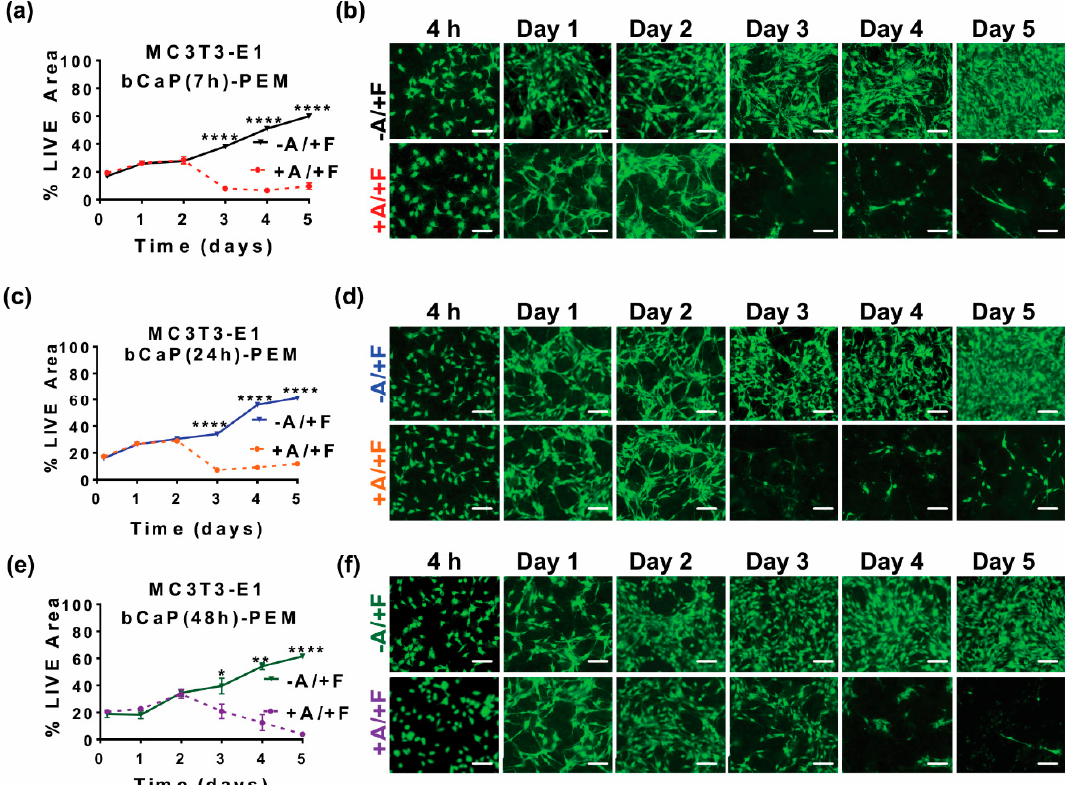
Figure 3. MC3T3-E1 osteoprogenitor cells cultured on bCaP of varying thickness with PEM present: ( a ) percent LIVE ® stained area of MC3T3-E1s cultured on bCaP(7 h)-PEM30-FGF2 without Antimycin A ( − A/+F) and AntiA-bCaP(7 h)-PEM30-FGF2 with Antimycin-A (+A/+F) (**** p < 0.0001); ( b )